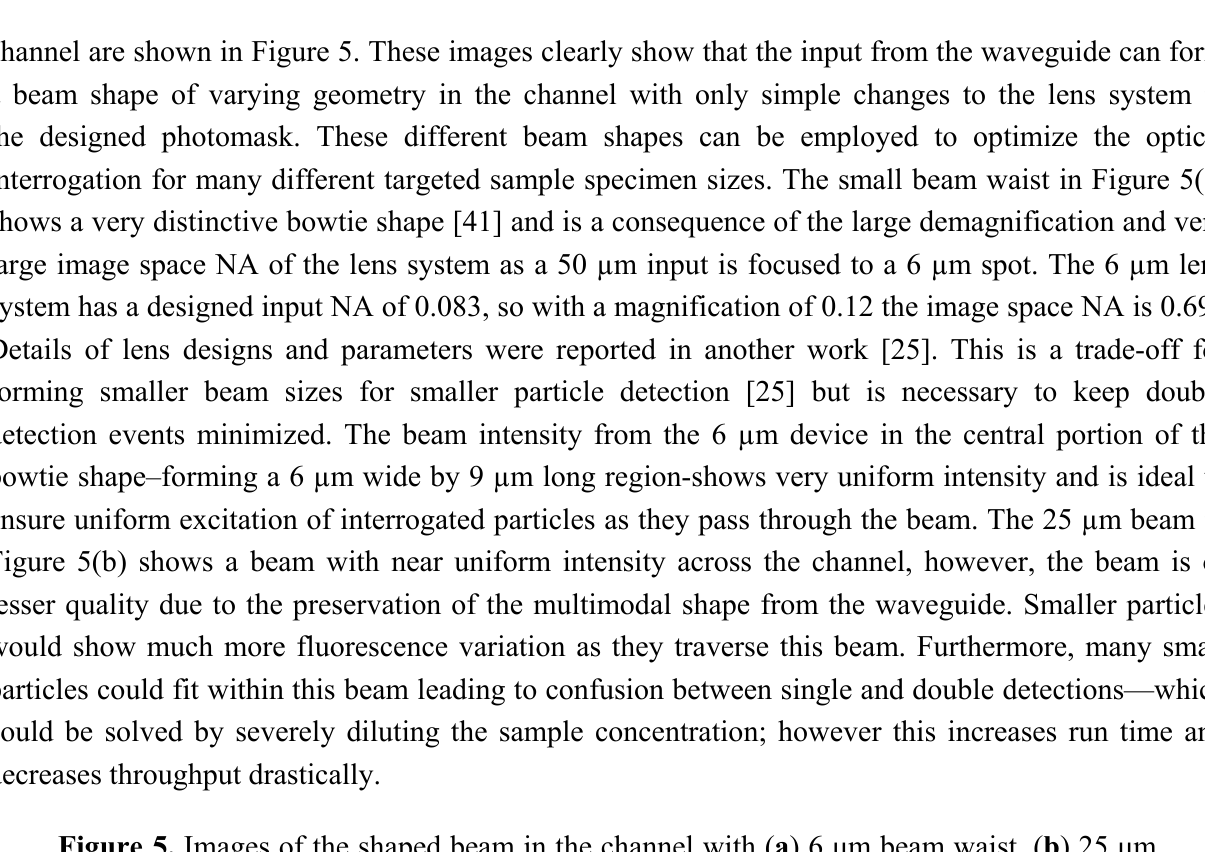
Figure 5. Images of the shaped beam in the channel with ( a ) 6 μ m beam waist, ( b ) 25 μ m beam waist. Light is injected from the bottom while beads flow left to right and would be confined into the centre (vertically) region of the